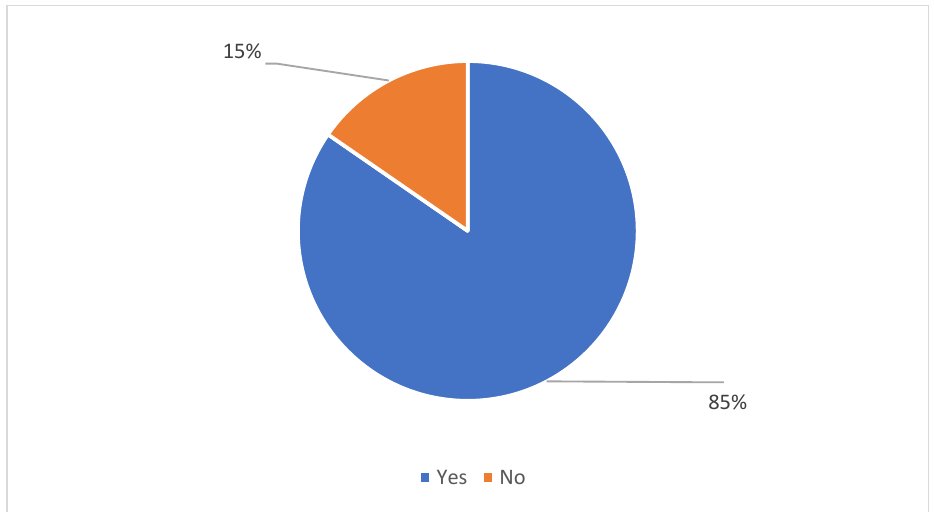
Figure 9. Importance of open data and data sharing in car-sharing systems.